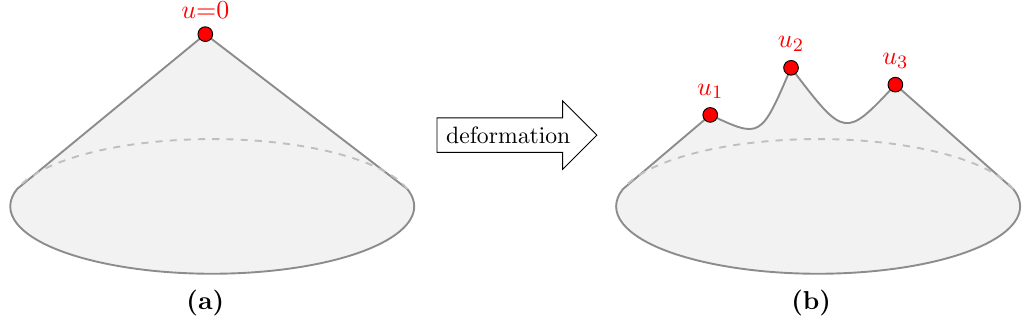
Figure 1 . (a) A planar, scale-invariant CB in the rank 1 case. The conformal vacuum is the tip of the cone, at u = 0, while at points with u = 0 conformality is spontaneously broken. (b) A typical 6 \near" deformation of the scale-invariant geometry, in which the conical singularity splits into several conical or cusp-like singularities, u = u i , without a(cid:11)ecting the asymptotically far geometry.